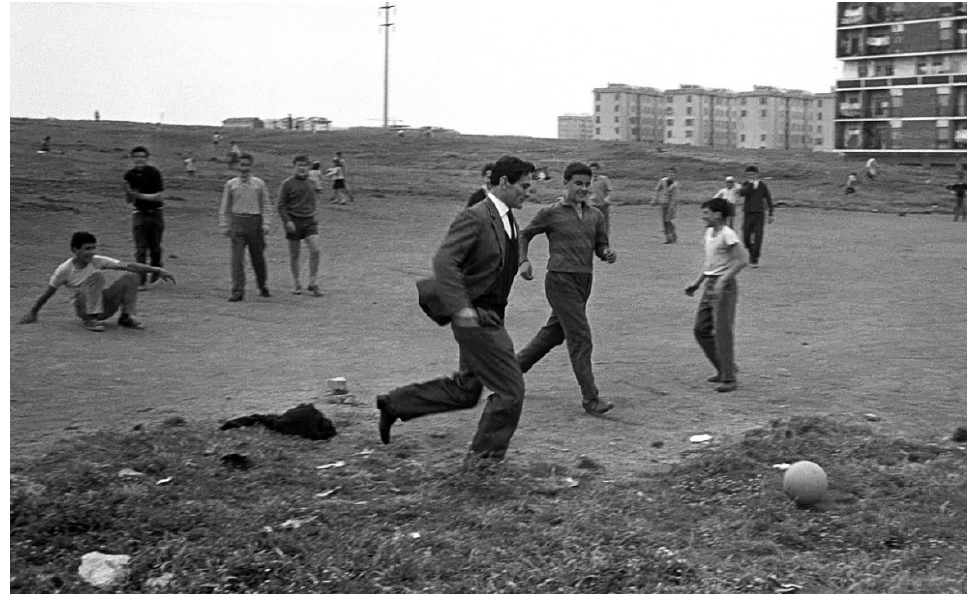
Figure 3. Rome, 1960. Pier Paolo Pasolini playing soccer with the boys of the Roman district of Centocelle. Photograph by Federico Garolla © Federico Garolla.